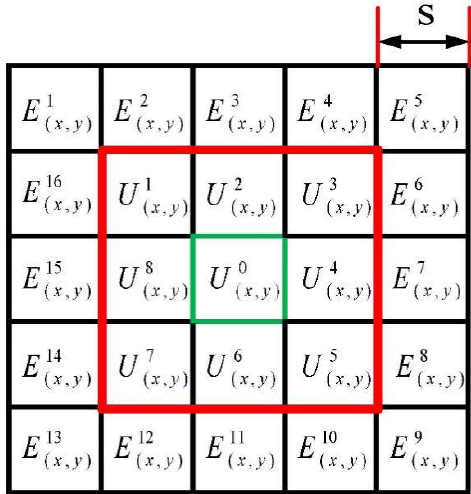
Figure 2. Multi-scale sliding window structure.